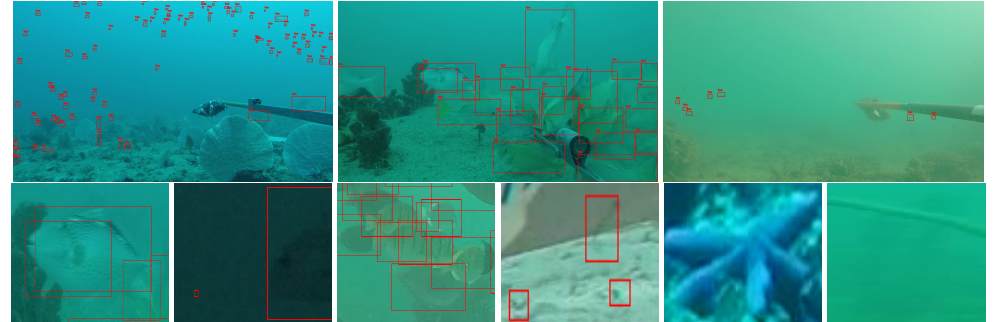
Figure 3. Top row: sample of OzFish dataset object detection images. Bottom row: examples of wrong annotations. From left to right: overlapped annotations over the same target, negligible small bounding box, reef, feeder structure, starfish, and floating rope, all annotated as